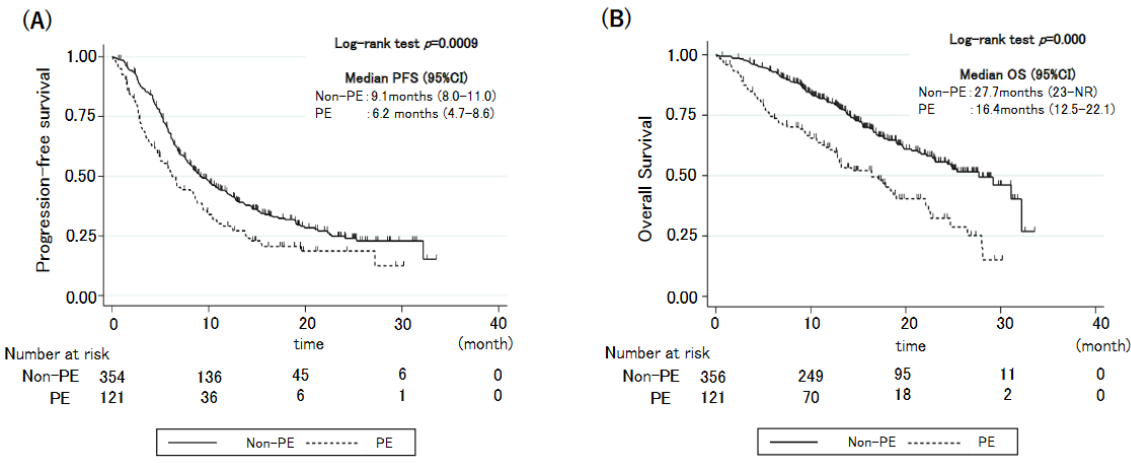
Figure 1. Kaplan-Meier curves for ( A ) progression-free survival and ( B ) overall survival based on the patient’s pleural effusion status . Table 3. Multivariate analysis of factors associated with progression-free survival and overall sur- vival.